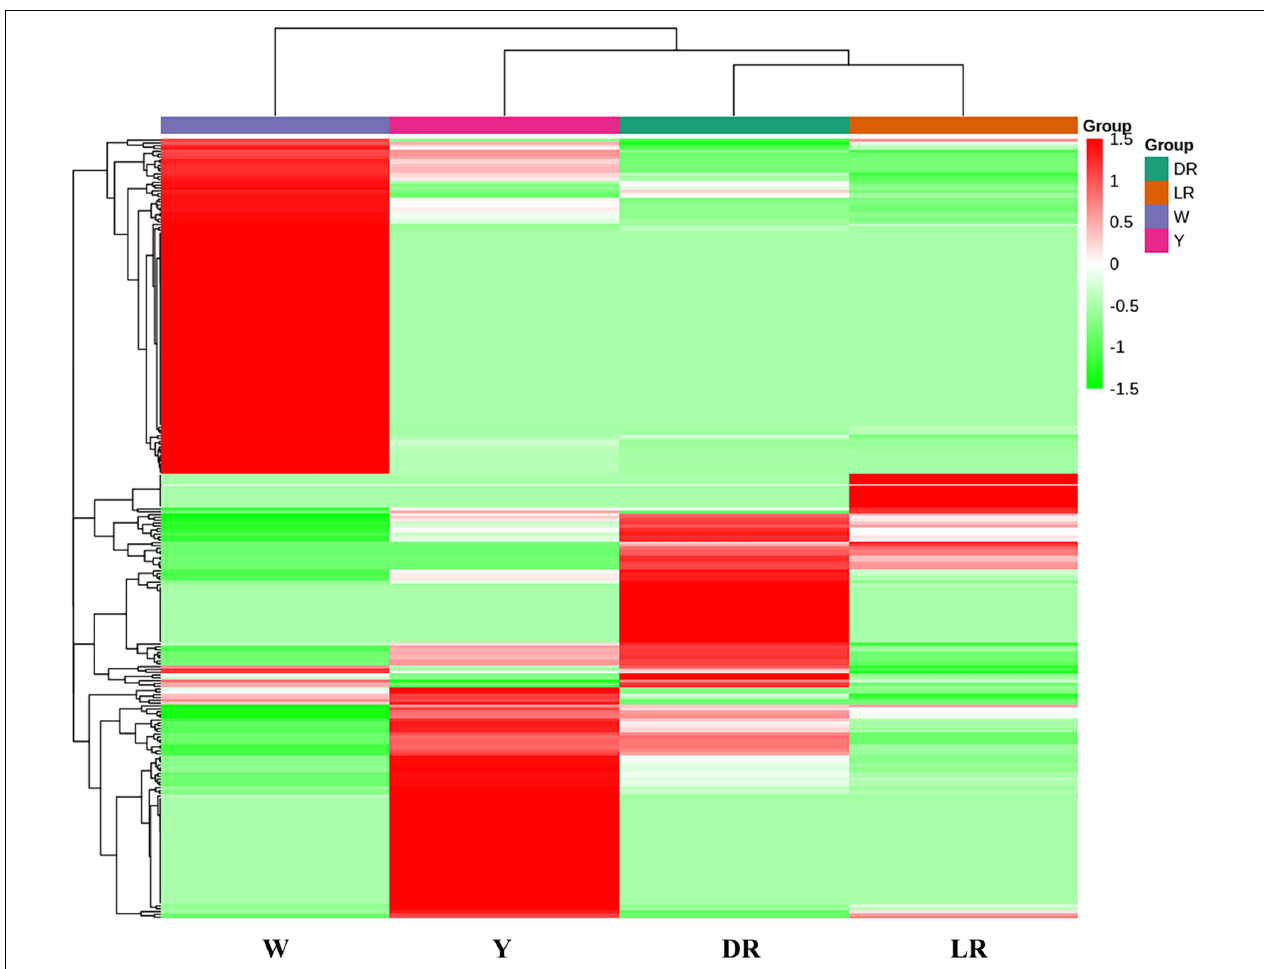
FIGURE 3 | Heatmap of flavonoid metabolic species among the four different-colored flowers of safflower. The heatmap was drawn based on the content of flavonoid metabolic species in the different color of safflower. W, white; Y, yellow; LR, light red; DR, deep